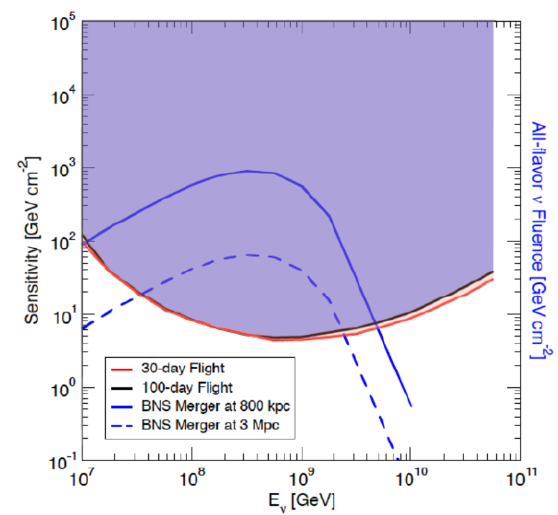
Figure 9: All-flavor long-duration transient sensitivity band for EUSO-SPB2 assuming a 30-day (red) or a 100- day (black) flight. For comparison, solid and dashed blue lines present the all-flavor neutrino fluences from the bi- nary neutron star merger model of [16], placing the source at various